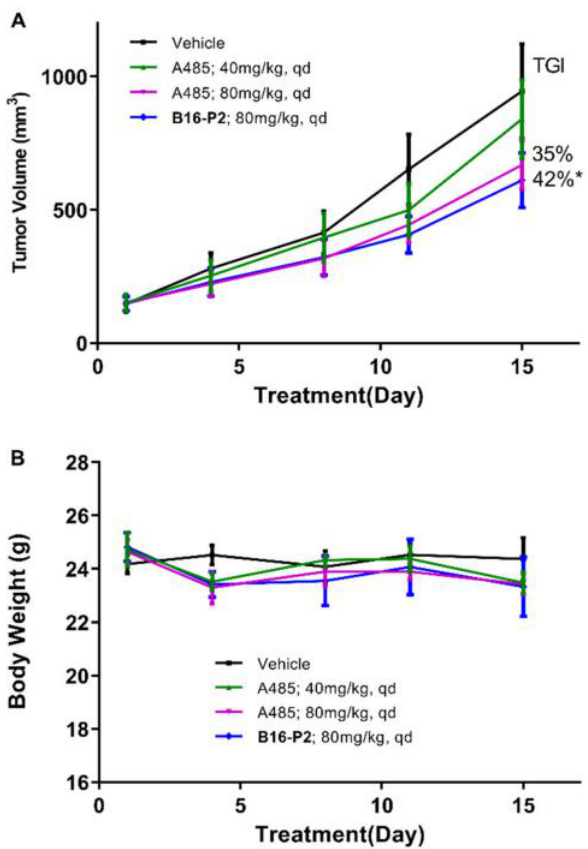
Figure 4. In vivo 22Rv1 xenograft model study of compound B16-P2 and A-485. ( A ) The tumor growth curve of four groups. ( B ) The body weights of mice over time ( n = 6, * p < 0.05 versus